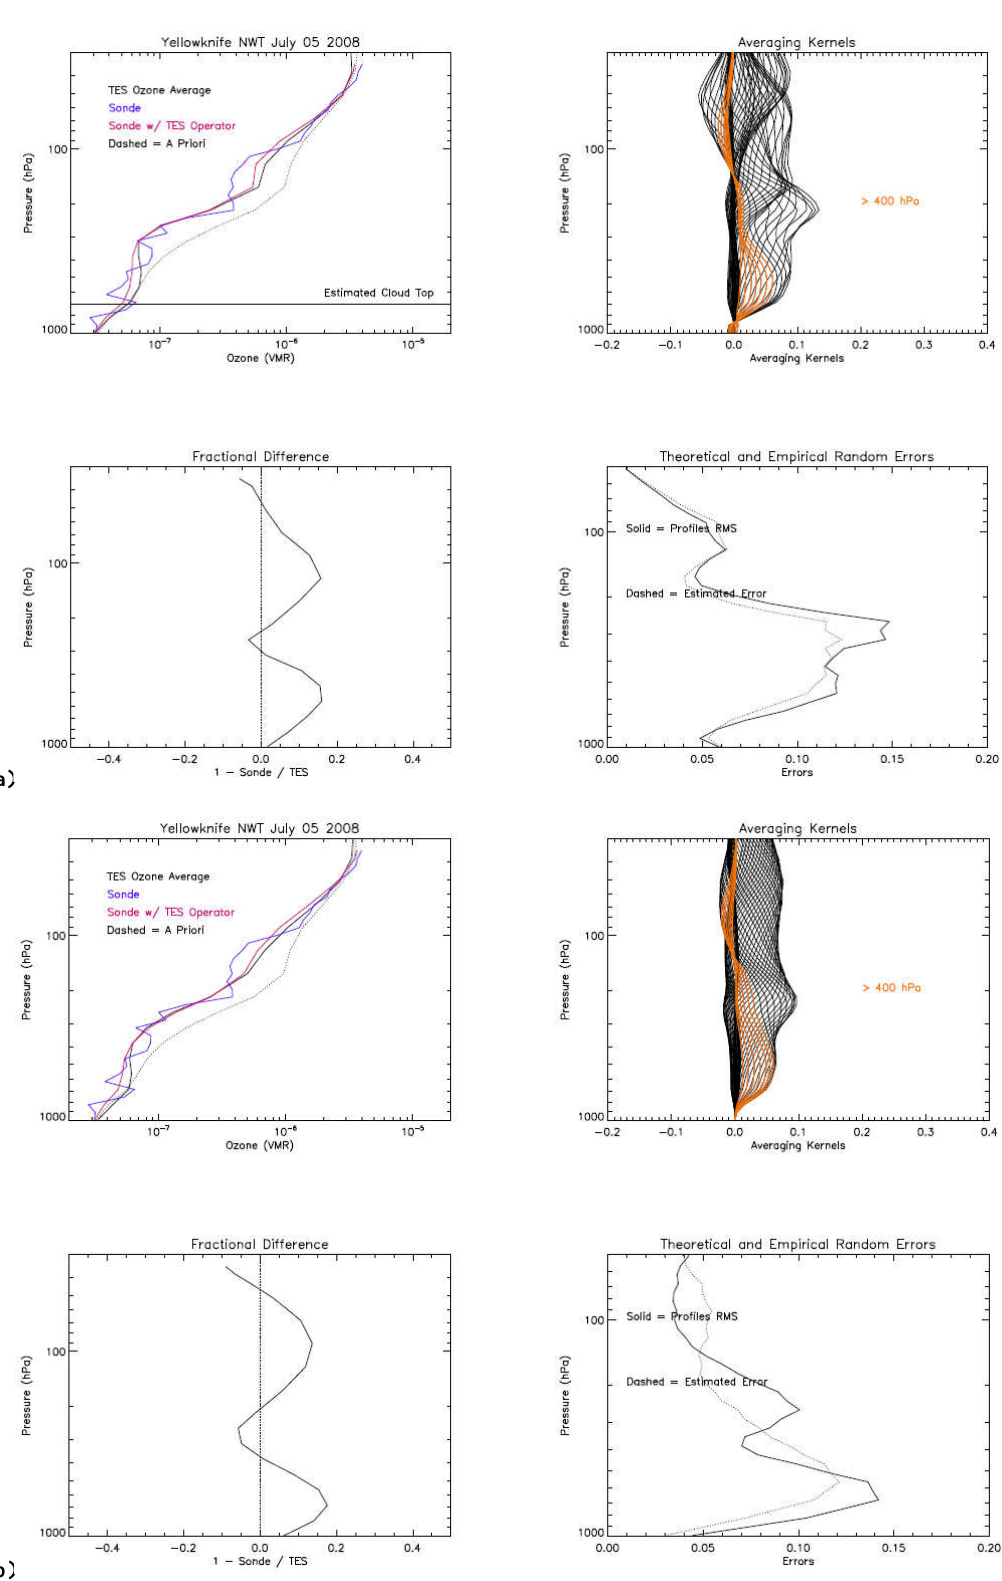
Fig. 3. The TES-stare sequence on 5 July 2008 over Yellowknife started at 20:19 (UTC), and the ozonesonde on that day at Yellowknife was launched at 20:07 (UTC), using V003 (a) and V004 (b) TES